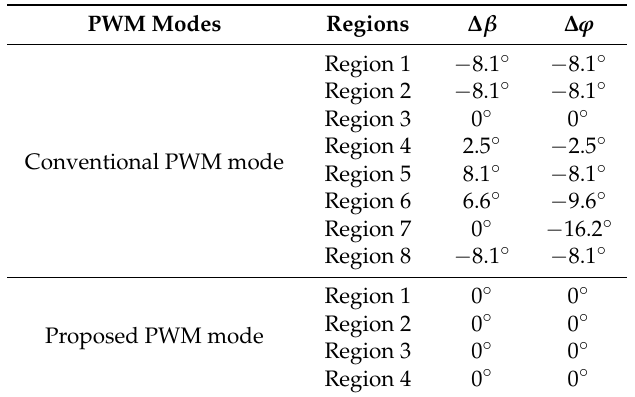
Table 2. Comparisons between conventional and proposed PWM